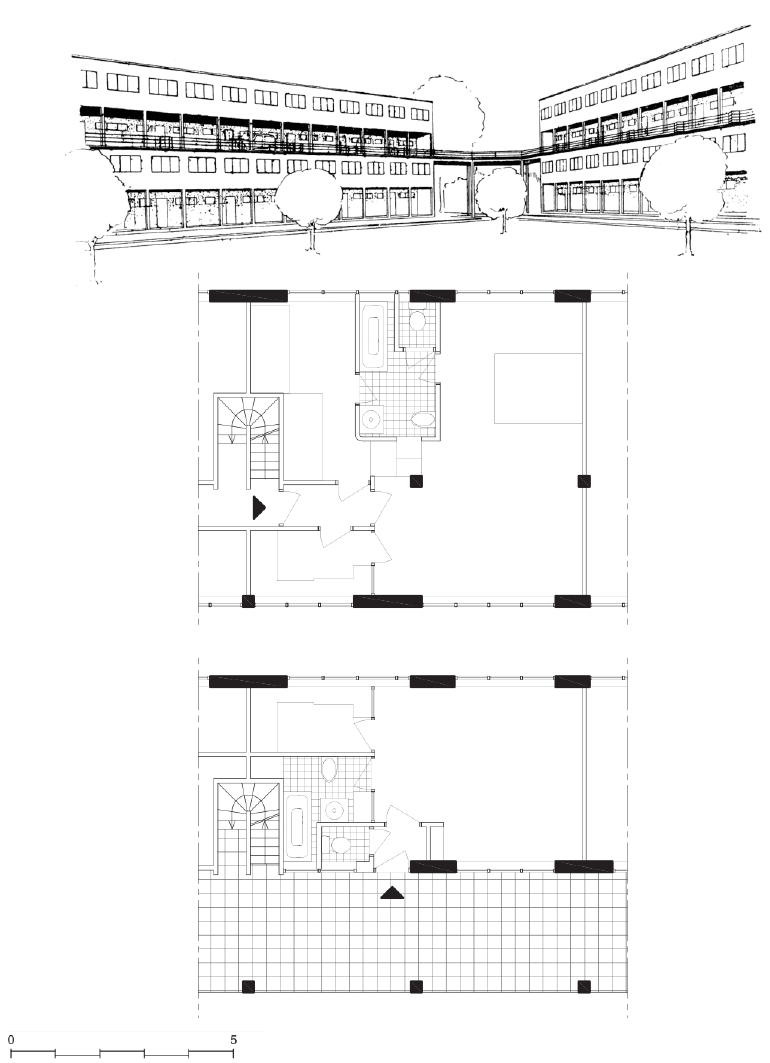
Figure 4. Bourgeois, Project for a garden city , 1927, later published in Die Wohnung für das Existenzminimum (drawings by the author and perspective drawing by Victor Bourgeois; Anonymous, 1929, p.